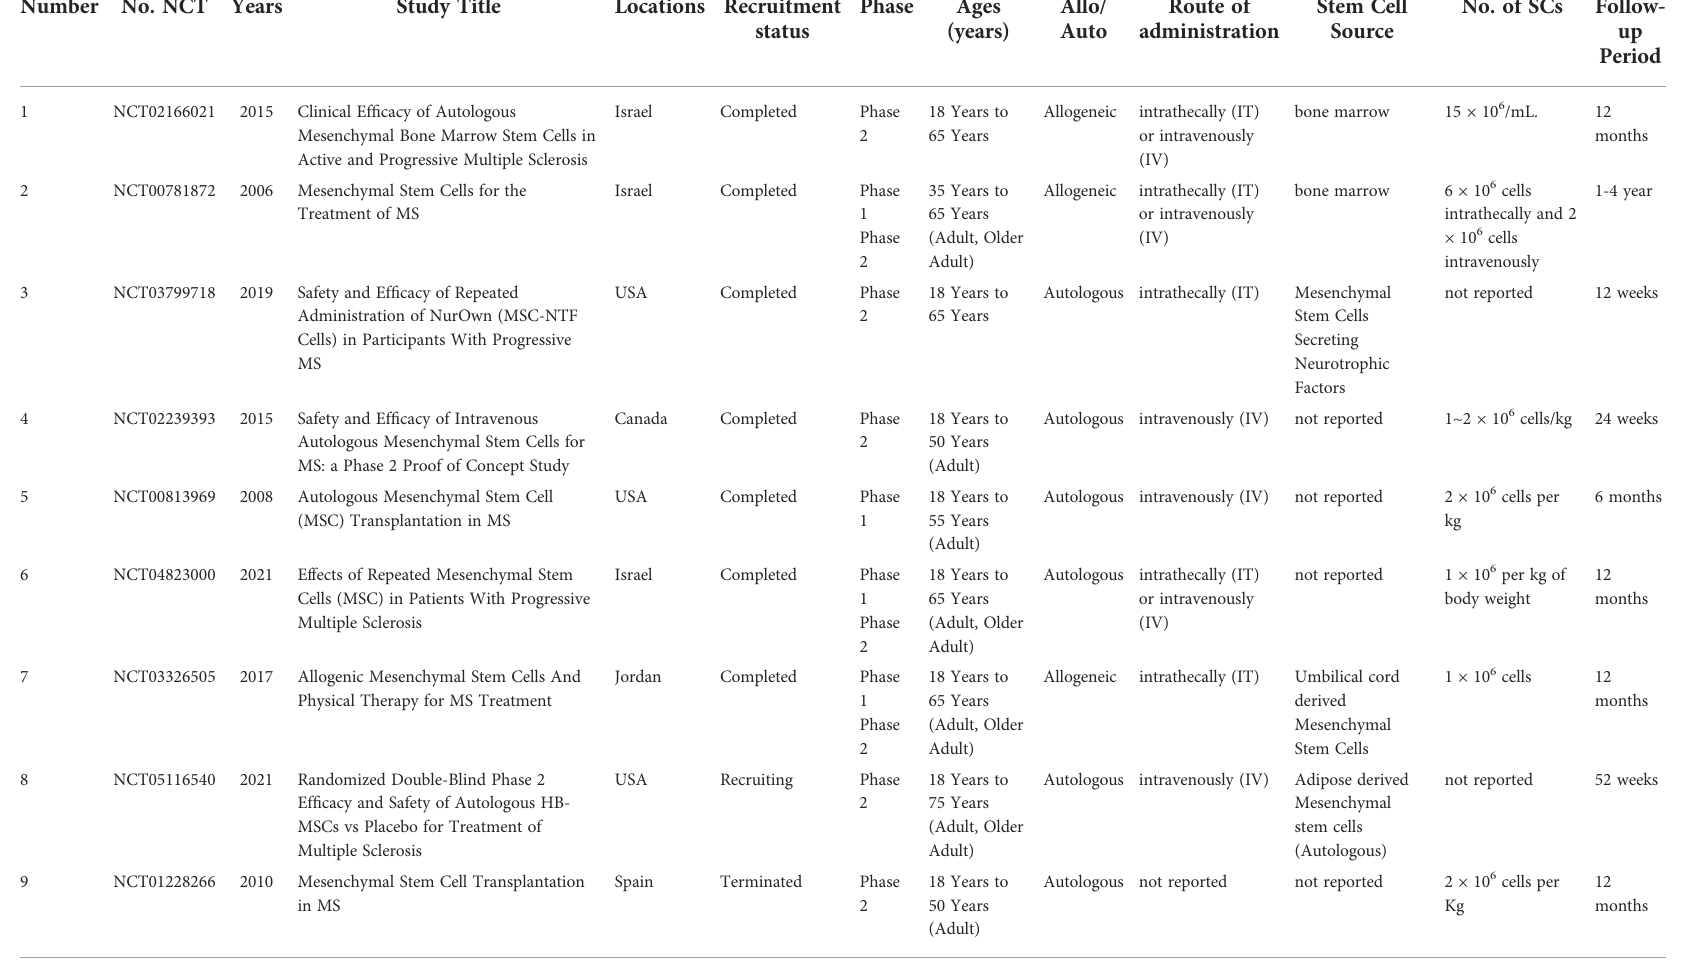
TABLE 3 Clinical studies using MSCs for treatment of